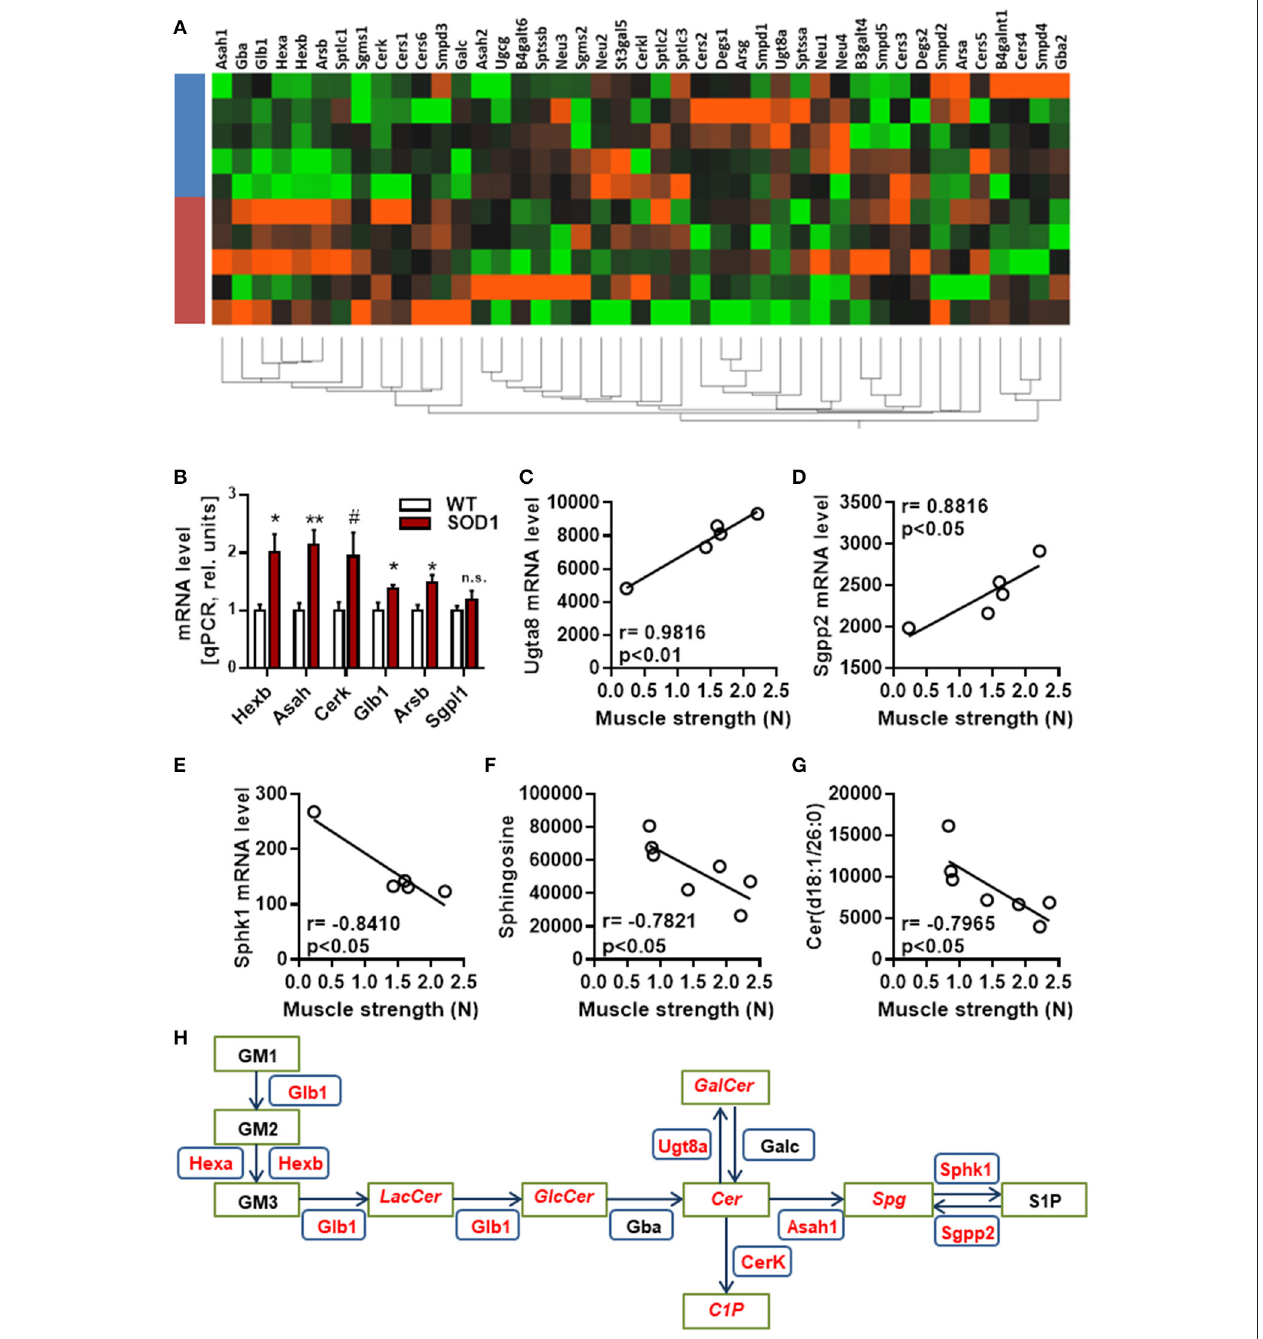
FIGURE 3 | Regulation and interaction of genes related to glycosphingolipid pathway. (A) Unsupervised hierarchical clustering, performed with genes from the KEGG pathway “sphingolipid metabolism pathway,” showing distribution of SOD1 G86R and wild type samples (blue, wild type; red, SOD1 G86R ). (B) Validation by qPCR of differential expression level of genes from the sphingolipid pathway previously found dysregulated by RNAseq. (C–G) Pearson correlations between muscle strength and gene expression levels of Ugt8a (C) , Sgpp2 (D) , Sphk1 (E) , and metabolite levels of sphingosine (F) and ceramide(d18:1/26:0) (G) . (H) Schematic representation of the main dysregulations related to glycosphingolipids, ceramide, and sphingosine. Green boxes represent metabolites and blue boxes refer to genes. In red are given genes and metabolites showing either altered levels or a correlation with disease severity. LacCer, lactosylceramide; GlcCer, glucosylceramide; GalCer, galatosylceramide; Cer, ceramide; Spg, sphingosine; S1P, sphingosine 1-phosphate, C1P, ceramide 1-phosphate. Gene abbreviation follows the HUGO Gene Nomenclature Committee -approved gene nomenclature. Data are presented as mean ± standard variation of the mean. n.s, not significant; # p < 0.1; * p < 0.05; ** p <